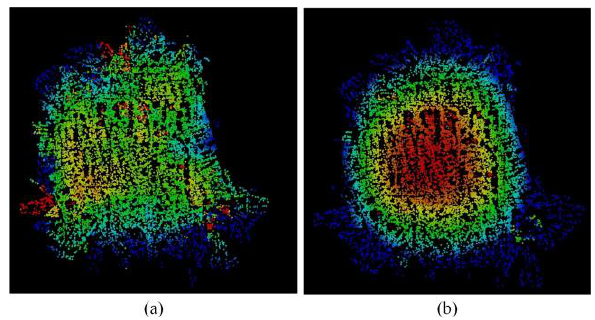
Figure 9. Parts of tracking map with thumbnail photos rotated. (a), (b) and (c) shows the details in track map with images rotated according to yaw angles calculated when initial image network generation in Case II.